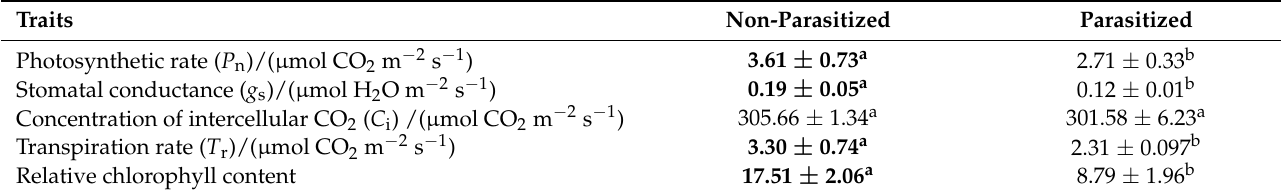
Figure 1 . Point of infection of Arabidopsis thaliana by Cuscuta australis ( a ) with arrows, showing the site of haustoria formation after 24 h and microscopic cross-section of haustoria (h) after 72 h ( b ). Table 1 . Effect of parasitism on the chlorophyll content and photosynthetic characteristics of the host. Data were shown as mean ± standard errors ( n = 6). Different small letters indicate significant (Student’s t -test) differences between parasitized and non-parasitized treatments.